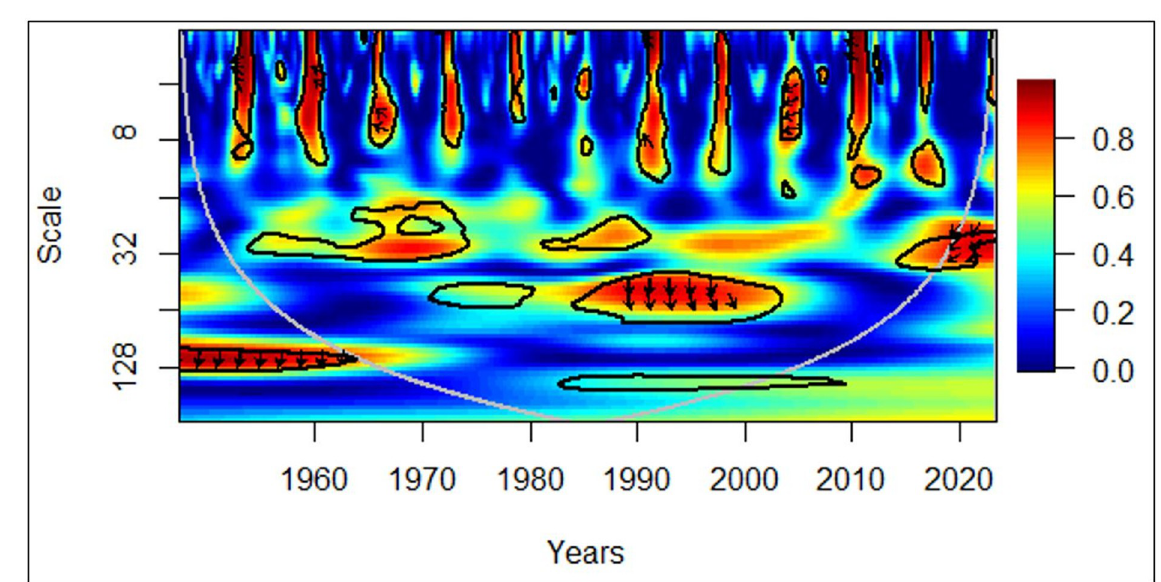
Fig 9. North American region: GDP vs EPOP. Source: Authors’ illustration. population. The rightward and downward arrows illustrate that economic growth leads the elderly population. In addition, in 2004, in the short-term (high frequency), the arrows facing left describe a negative correlation between economic growth and the elderly population. The leftward and downward arrows show that the elderly population leads to economic growth.